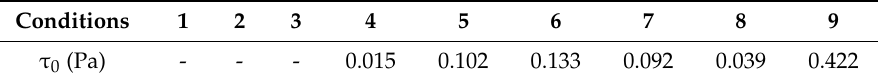
Figure 7. The shear strain of ultrafine scheelite pulp as a function of shear stress under different conditions (pH 10). Table 1. The shear yield stress of scheelite pulp under different conditions.